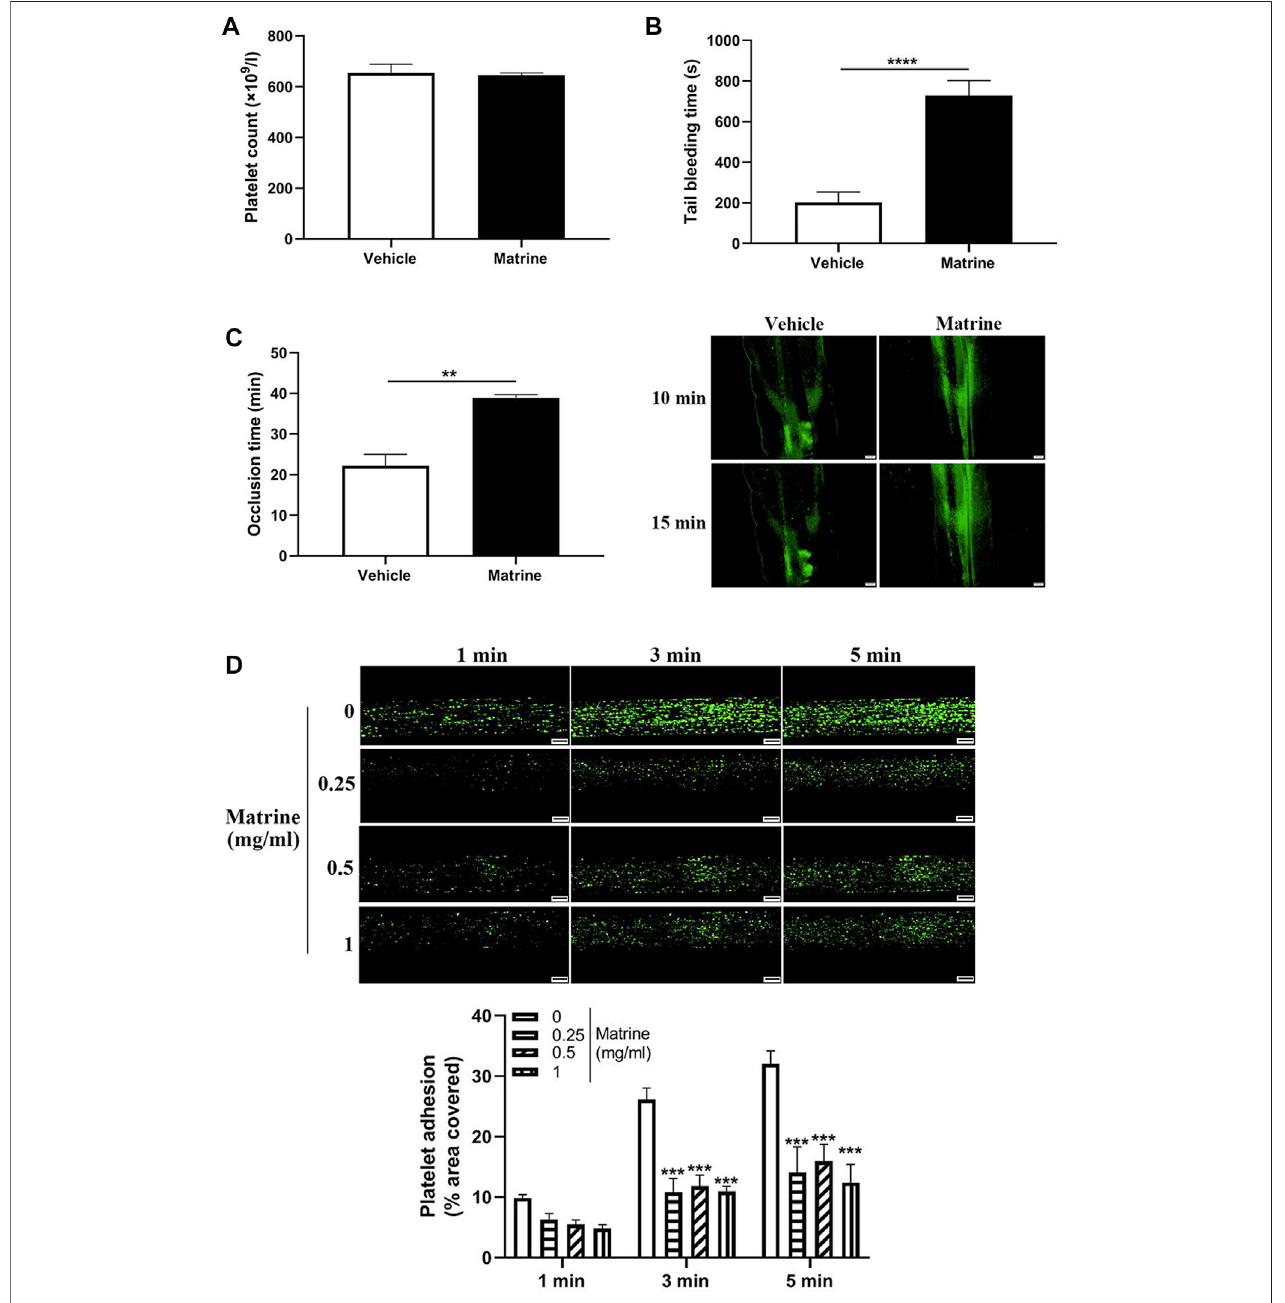
FIGURE 4 | Effect of matrine on hemostasis and arterial thrombosis in mice . Mice received intraperitoneal injection of matrine (10 mg/kg) followed by analysis of platelet count (A) , tail bleeding time (B) , and arterial thrombus formation induced by FeCl 3 which was monitored by a fl uorescence microscopy (Olympus BX53) (mean, n (cid:2) 6) (C) . Human blood labelled with mepacrine (100 μ M) was perfused through Bio fl ux plates in a micro fl uidic whole-blood perfusion assay followed by monitoring the thrombus formation under a fl uorescence microscopy. The platelet-covered area was quanti fi ed using Bio fl ux software (Fluxion) (D) . Scale bar (cid:2) 100 μ m. Data were presented as mean ± SE ( n (cid:2) 6 – 9). ** p < 0.01 and **** p < 0.0001. Compared with 0, *** p < 0.001.